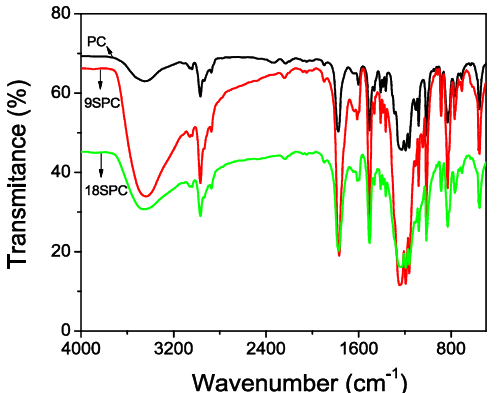
Figure 2. Infrared spectra of PC, 9SPC and